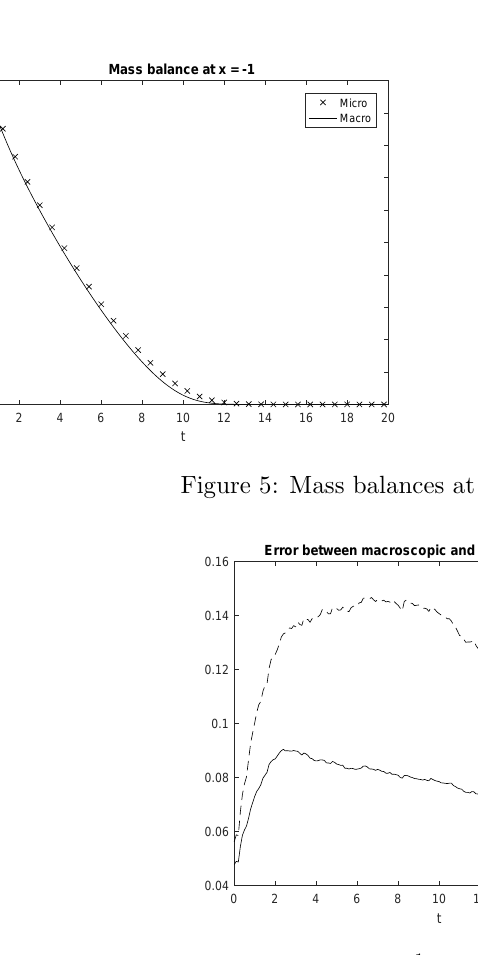
Figure 6: L 1 and L 2